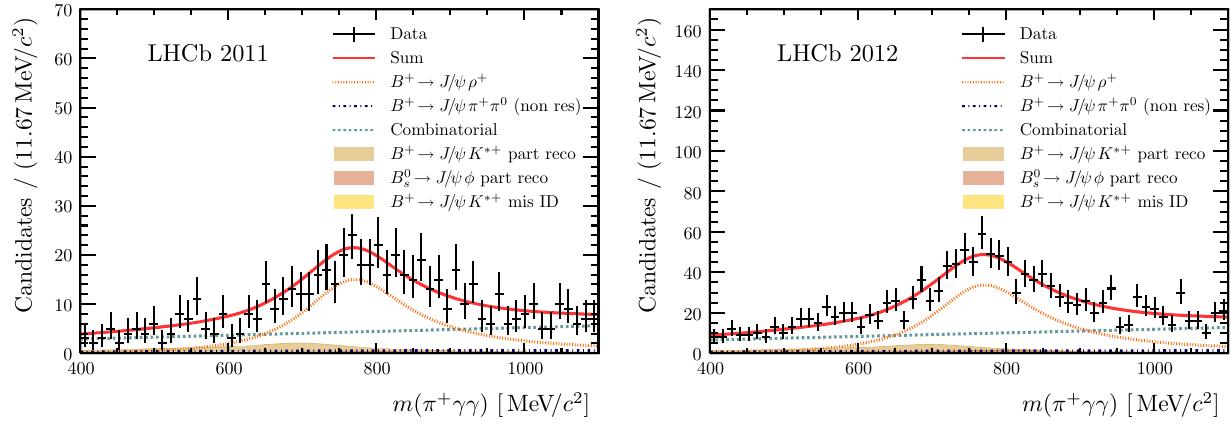
Fig. 4 The π + γγ invariant mass distributions for the (left) 2011 and (right) 2012 data sets for m J /ψπ + π 0 between 5250 and 5310MeV / c 2 . The part reco and mis ID backgrounds are small in the given mass region and not visible in these figures